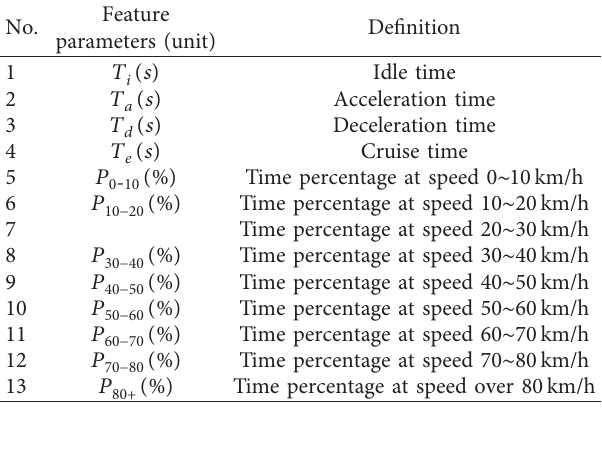
Table 2: Feature parameters for the validity assessment of the kinematic